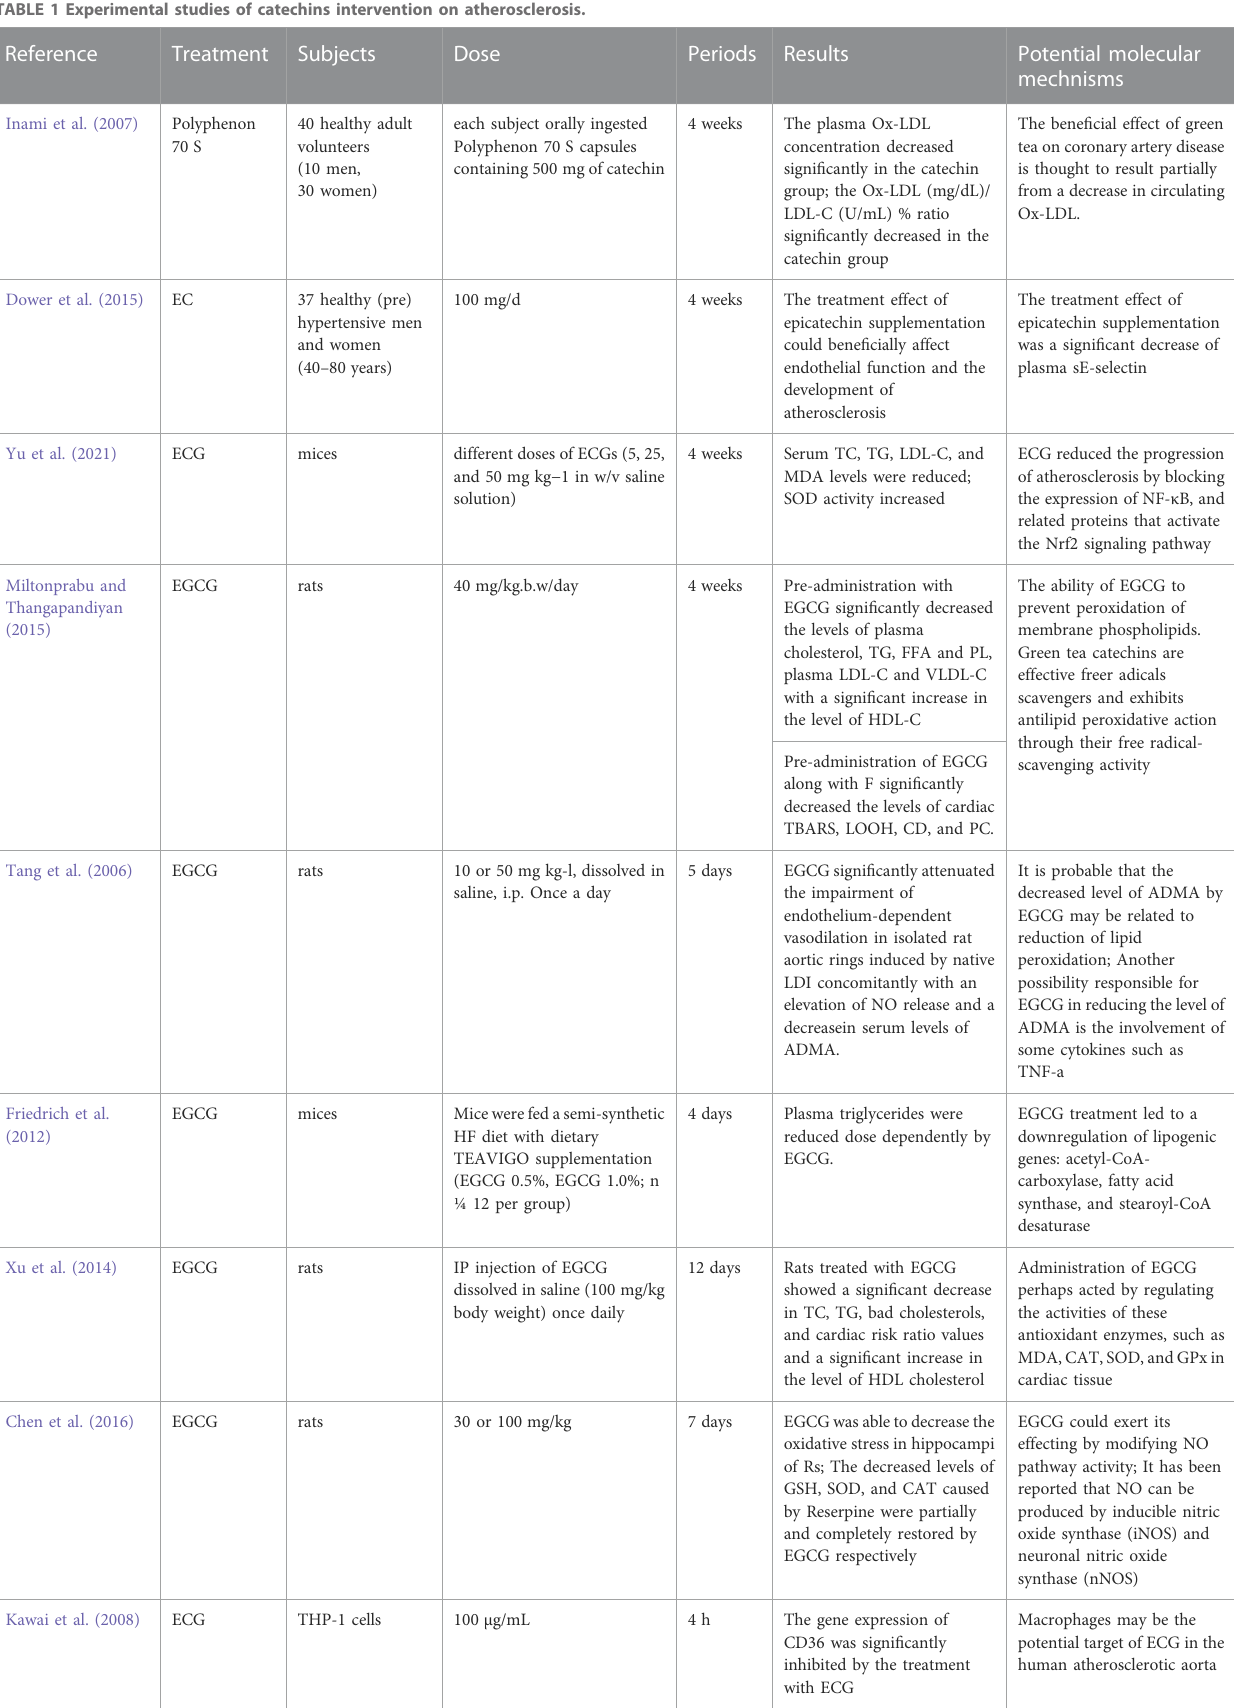
TABLE 1 Experimental studies of catechins intervention on